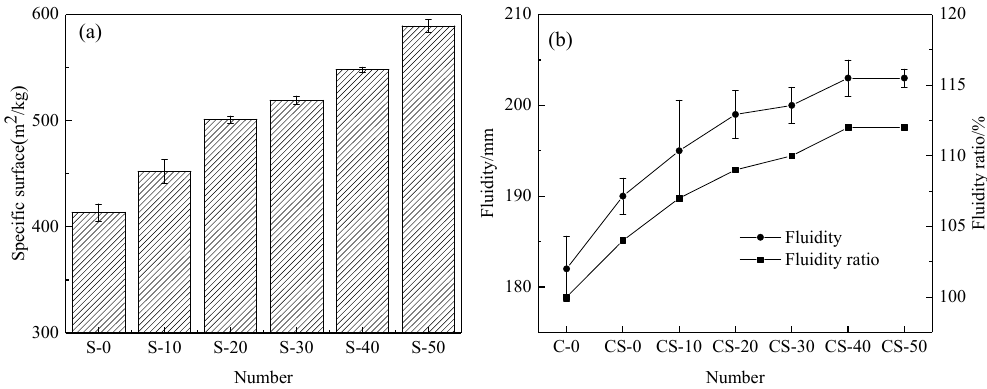
Figure 6. Specific surface area and workability of the slag-tailing: ( a ) Specific surface area when ground for 30 min; ( b ) fluidity and fluidity ratio of mortars.